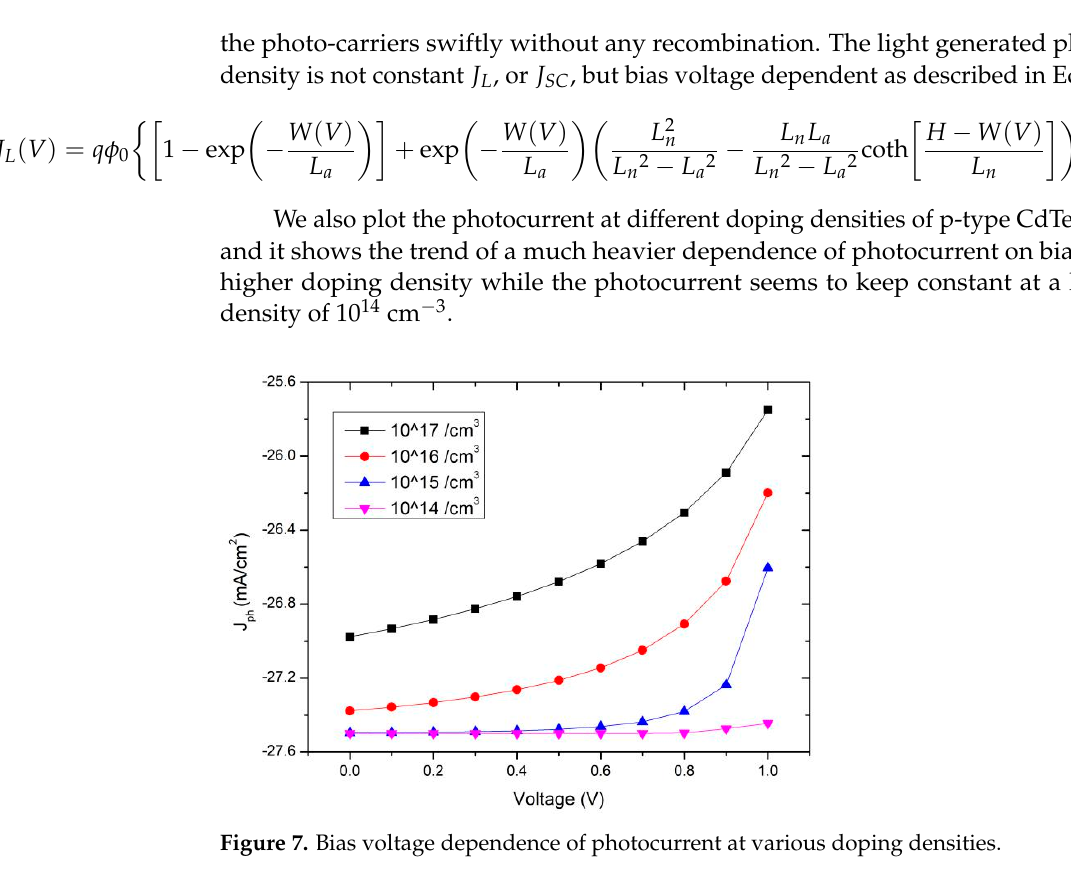
Figure 8. The comparison of our experimental data and theoretical model.